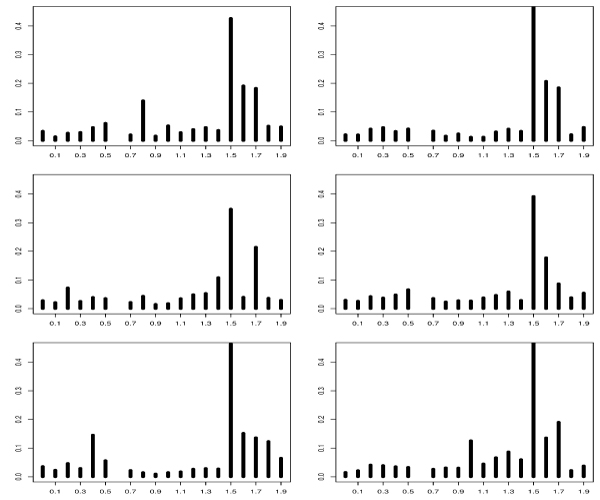
Posterior distribution for functional mutation in first 6 replicates for phenotype e. The figure shows the posterior distribution for the location of the functional mutation related to trait e in a phase-unknown analysis of each of the first 6 replicates of the packet 153 data.